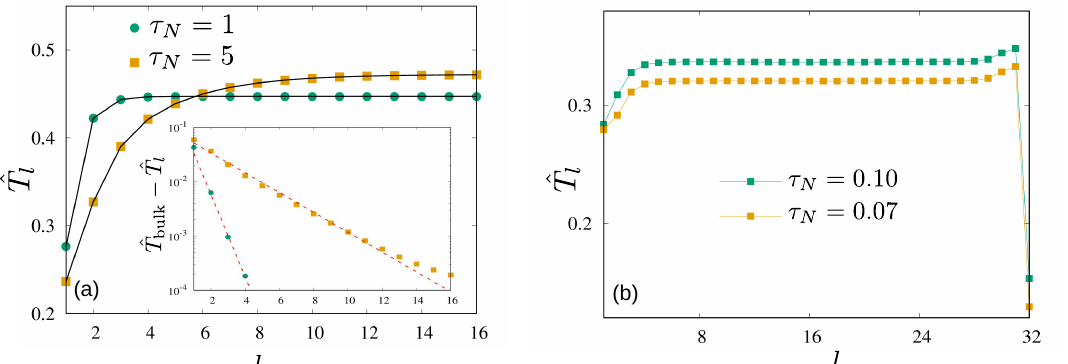
Figure 6: Boundary layer properties of the kinetic temperature profile: (a) shows ˆ T profile near the left boundary. The main plot compares the contributions from l Eq. (B.13), (B.18) and (B.21) (in solid black lines) with numerical simulations (in colored symbols). The inset plot shows the exponential decay of ˆ T left boundary for a system of N = 64 oscillators with m = 1, k = 1, γ = 1 and τ (b) shows the absence (presence) of the boundary kinks when τ = 2 (cid:112) k / m . Here N = 32 with m = 1, k = 0.5, γ = 1 and τ (smaller) than ω c